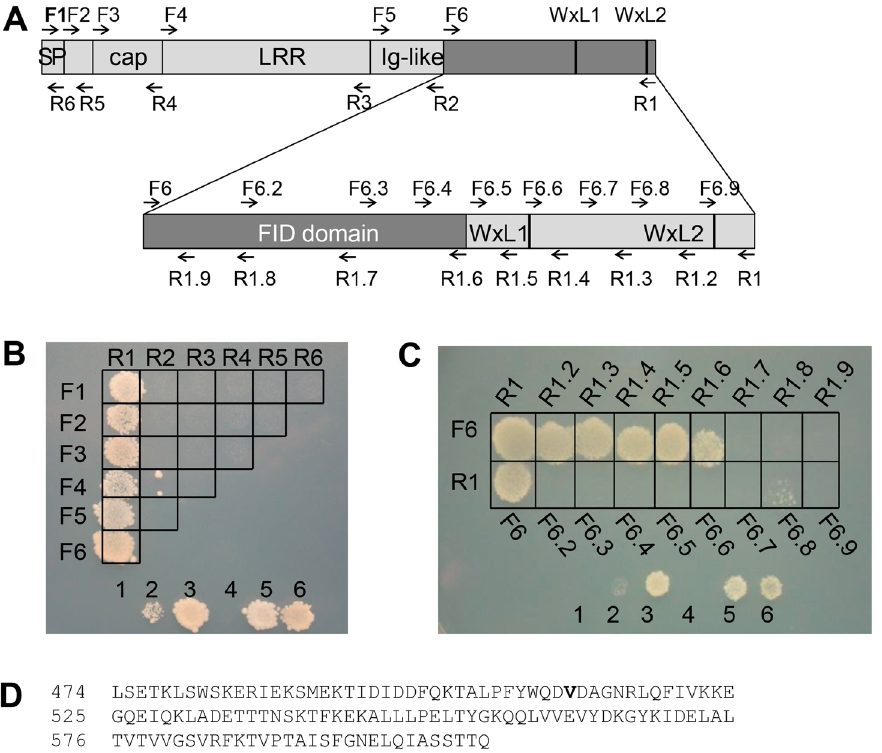
Figure 3. Determination of the ElrA minimal domain interacting with FHL2. ( A ) Schematic representation of ElrA with a zoom on the C-terminal region, known as the WxL domain. The forward and reverse primers used to generate the ElrA fragments are shown as F and R, respectively. The correspondence between the position of primers and the ElrA amino acids is detailed in Table S1. Symbols: SP, signal peptide, cap, cap domain, LRR, Leucine rich repeat domain, Ig-like, Immunoglobulin-like domain, and WxL, anchor domain with the WxL1 and WxL2 motifs are represented as thick dark bars. ( B ) Y2H interaction matrix between FHL2 and the 21 ElrA fragments generated with the primers F1 to F6 (lanes) and R1 to R6 (columns). Accordingly, the first box on the top left of the figure corresponds to the F1-R1 amplicon i.e . the full-length ElrA. ( C ) Y2H interaction matrix between FHL2 and the 17 ElrA fragments generated with the F6 to F6.9 and the R1 to R1.9 primers. The minimal FHL2 Interacting Domain (FID) spans from primers F6 to R1.6. ( D ) Amino acid sequence of the FID domain. In ( B ) and ( C ), the yeast strains used as controls are containing the following vectors 1, pPC97-CYH (DB-empty) and pPC86 (AD-empty), 2, DB-RB1 and AD-E2F-1, 3, DB-fos and AD-jun, 4, pPC97 (DB-empty) and pPC86 (AD-empty), 5, DB-DP1 and AD-E2F1, 6, DB-FRM-3 and AD-PKc_like.